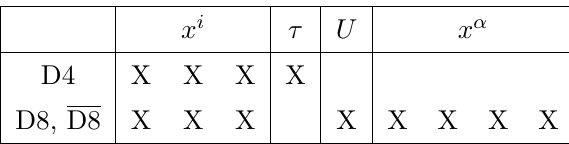
Table 1 . Brane configuration and coordinate labels in the WSS model. x µ = ( x 0 , x i ) denotes the coordinates common to both color and flavor branes, which span the field theory directions. The N c color D4-branes wrap the compact τ direction, where the N f flavor D8’s are localized in this direction. The flavor branes are extended in the remaining 5 directions: a radial coordinate U and an S 4 parameterized by x α